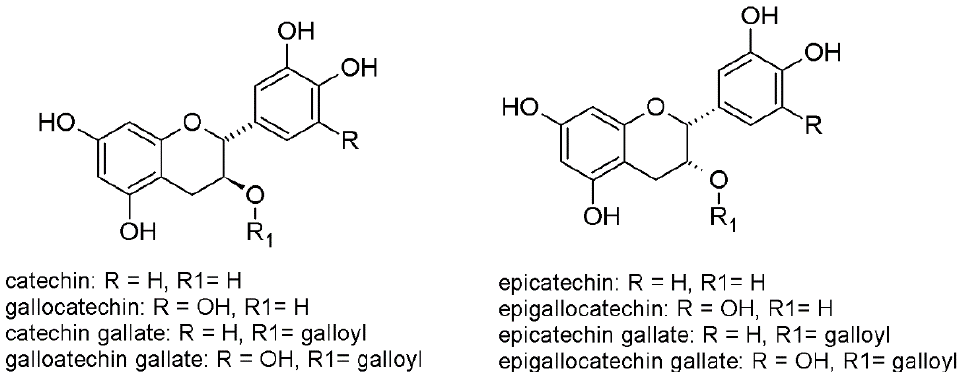
Figure 1. Chemical structures of the major monomeric flavan-3-ols found in grapes and